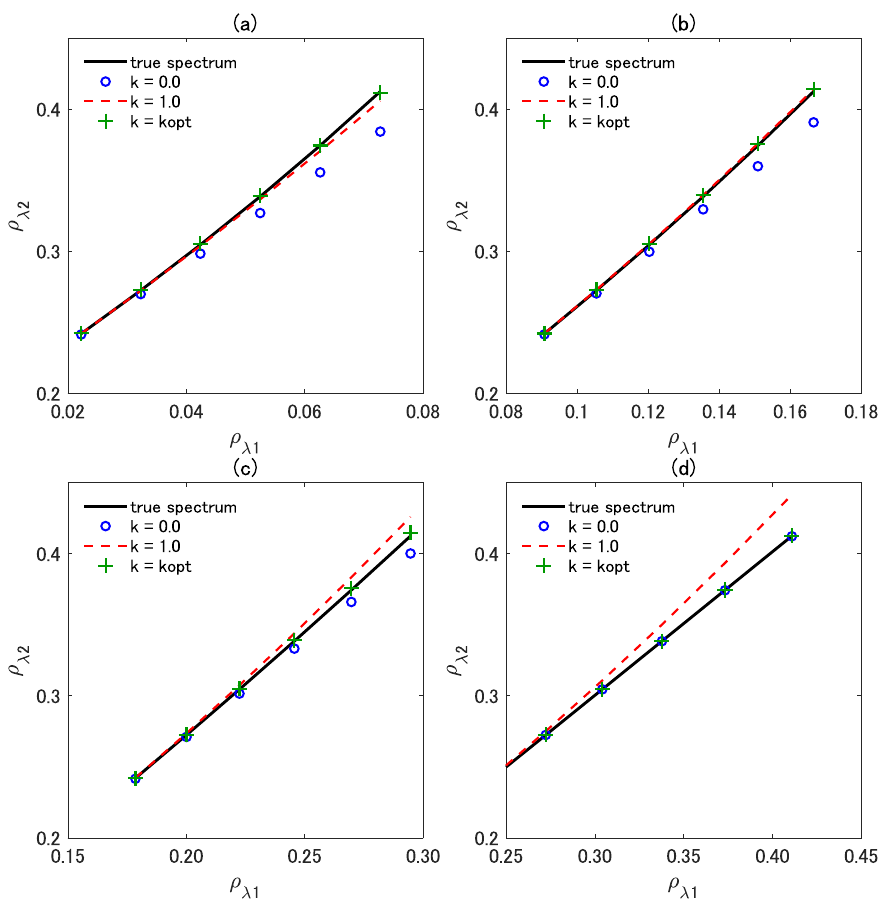
Figure 9. Scatter plot of true spectra and the three variants of isoline equations in the reflectance subspace. The wavelength λ 2 was fixed at 860 nm, whereas λ 1 was selected from ( a ) 690 nm, ( b ) 710 nm, ( c ) 730 nm, and ( d ) 850 nm ( λ 1 minus